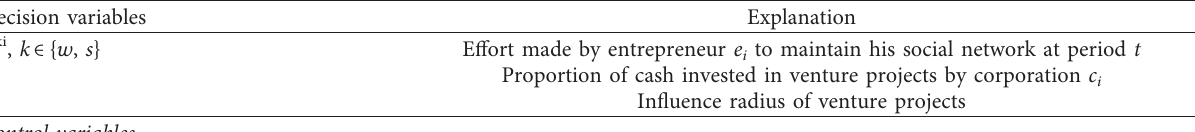
Table 1: Notations in